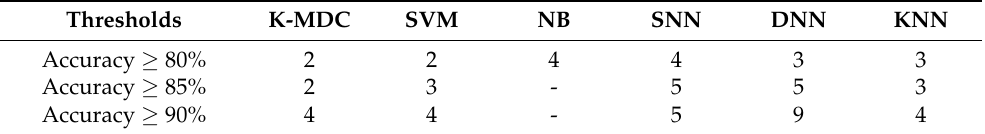
Table 3. Minimum required number of features to achieve specific detection accuracies. ‘-’ indicates that the classifier could not achieve the required accuracy threshold using our dataset.